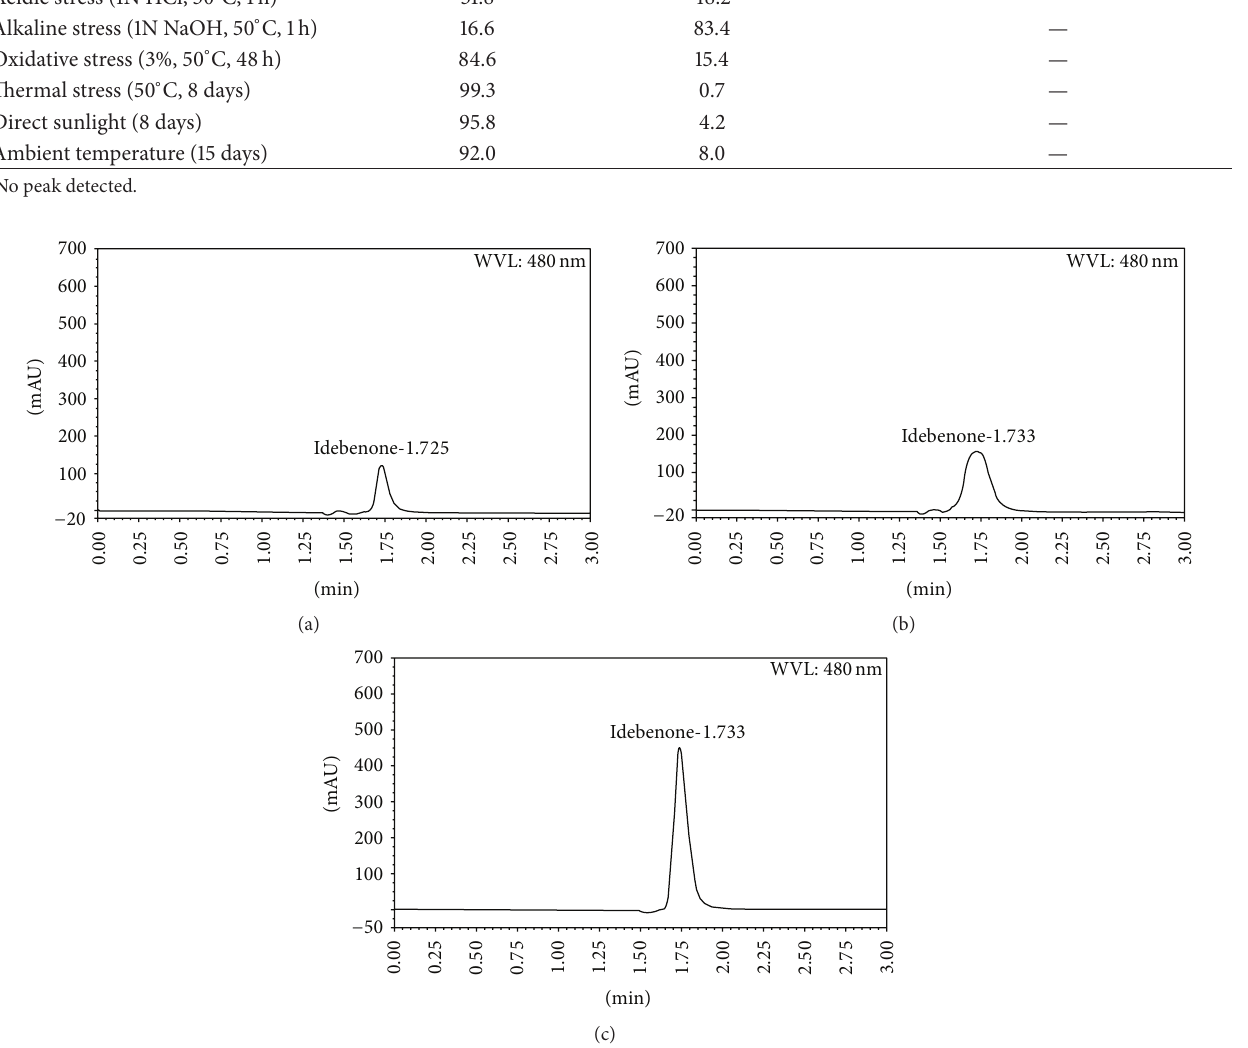
Figure 4: Chromatograms of 1N HCl (a), 1N NaOH (b), and oxidative (c) stress